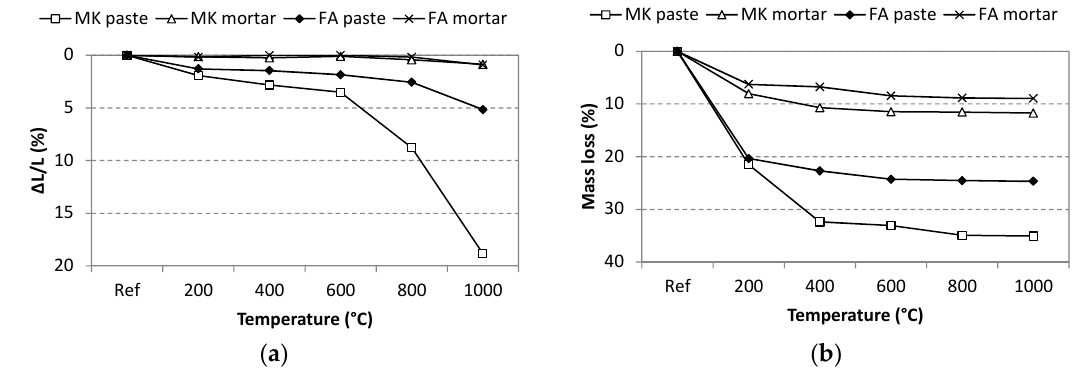
Figure 5. Thermal shrinkage ( a ) and mass loss ( b ) of geopolymer samples.